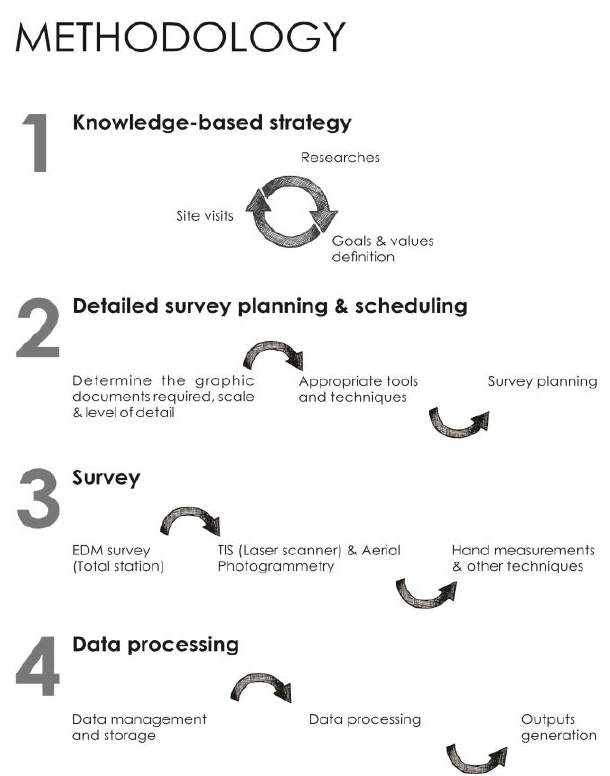
Figure 6. Scheme of the methodology followed for the survey of the Strutt House, by Pierre Jouan.